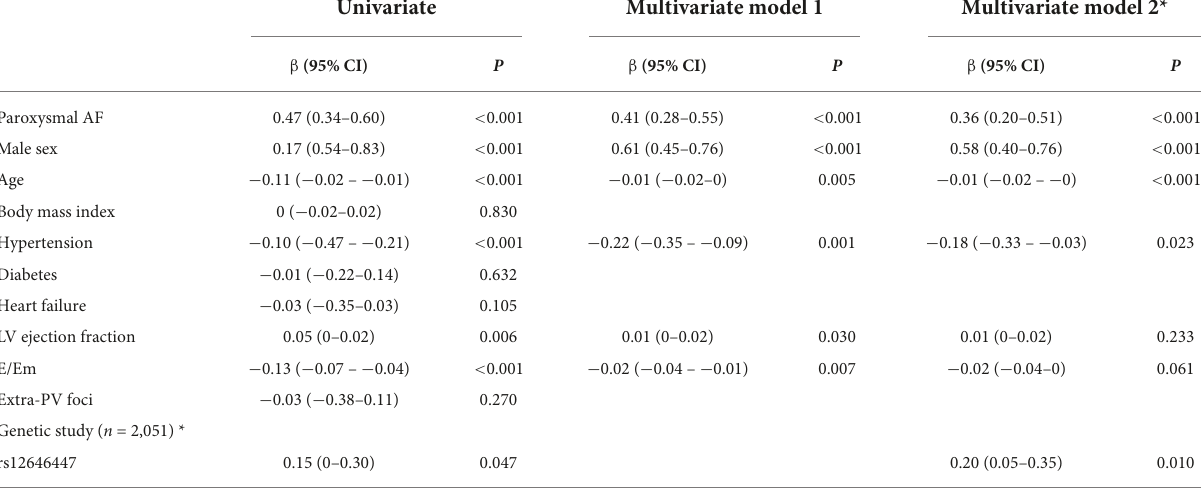
TABLE 3 Linear regression analysis for PV/LA%vol. Univariate Multivariate model